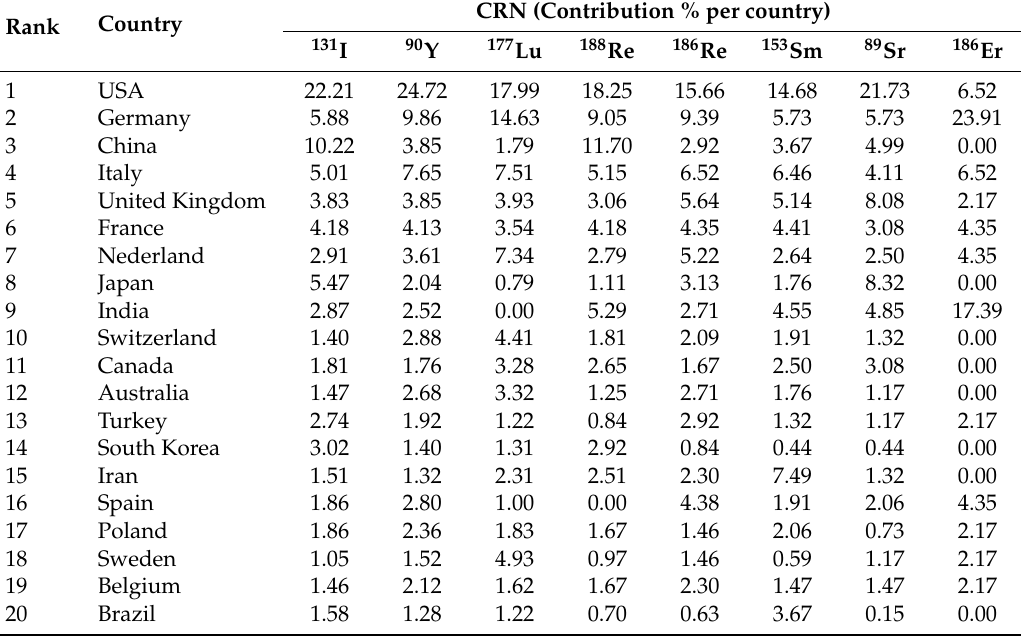
Table 8. Analysis of the popularity of different conventional radionuclides by the top 20 countries with the highest number of relevant publications (2008–2018). Highlighted in grey are the two highest percentages for each conventional